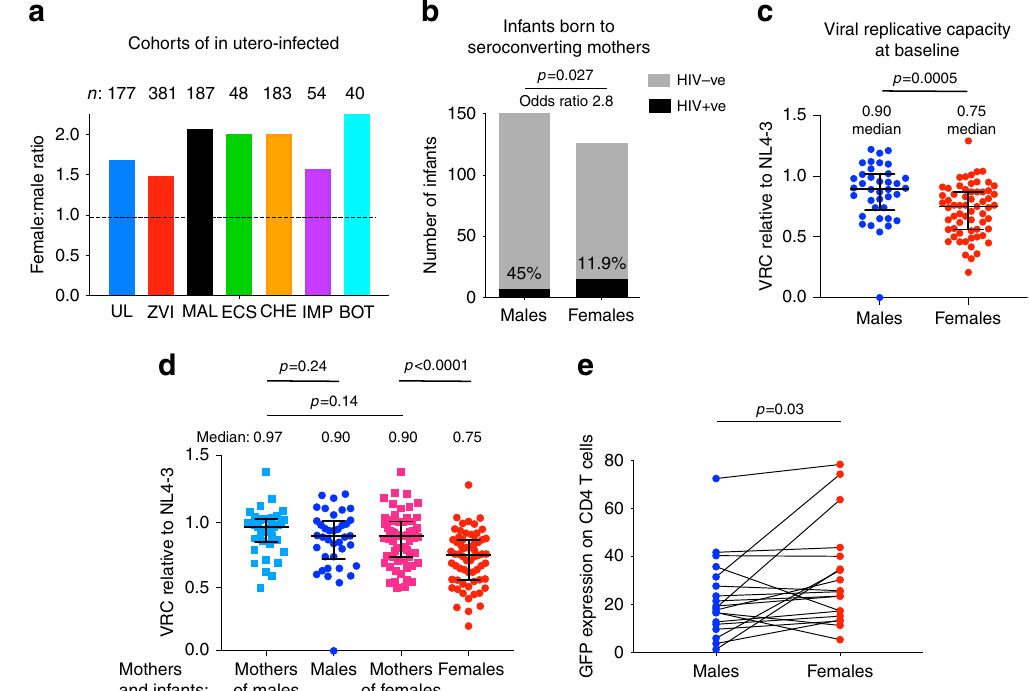
Fig. 1 Increased female susceptibility to in utero HIV infection compared to males. a Female:male sex ratio in the current Ucwaningo Lwabantwana cohort of in utero HIV-infected infants and in six other similar cohorts. UL: Ucwaningo Lwabantwana; ZVI: Zvitambo 9 ; MAL: Malawi 10 ; ECS: European Collaborative Study 11 ; CHE: CHER; IMP: IMPAACT P1115; BOT: Botswana. These data refer to in utero infected infants only, except for the CHER study which included intra-partum and in utero infected infants. b Numbers of male and female infants exposed to mothers seroconverting during the pregnancy (a negative HIV antibody test followed later in the pregnancy by a positive antibody test) at Queen Nandi Hospital, Empangeni, Stanger Hospital, Stanger, and Mahatma Gandhi Memorial Hospital, between 2016 and 2018, and numbers of in utero infected infants. The numbers of exposed infants did not differ signi fi cantly between the sexes but the number of infections did ( p = 0.027, 2-tailed, Fisher ’ s Exact test). c , d Viral replicative capacity at baseline from 101 in utero infected infants, 63 females and 38 males, and mothers. Data are presented showing medians and interquartile ranges. In panel ( c ), the statistical test used was the Mann – Whitney test. In panel ( d ) the statistical tests used were the Wilcoxon matched-pairs signed rank test (comparing males versus mothers of males), the unpaired paired t test (comparing mothers of males versus mothers of females) and the paired t test (comparing females versus mothers of females). In all cases P values were two-tailed. e In vitro HIV infection of cord blood CD4 + T-cells from 19 pairs of HIV-uninfected sex- discordant twins. The statistical test used was the Wilcoxon matched-pairs signed rank test (2-tailed). For Fig. 1c – e, source data are provided as a Source Data fi